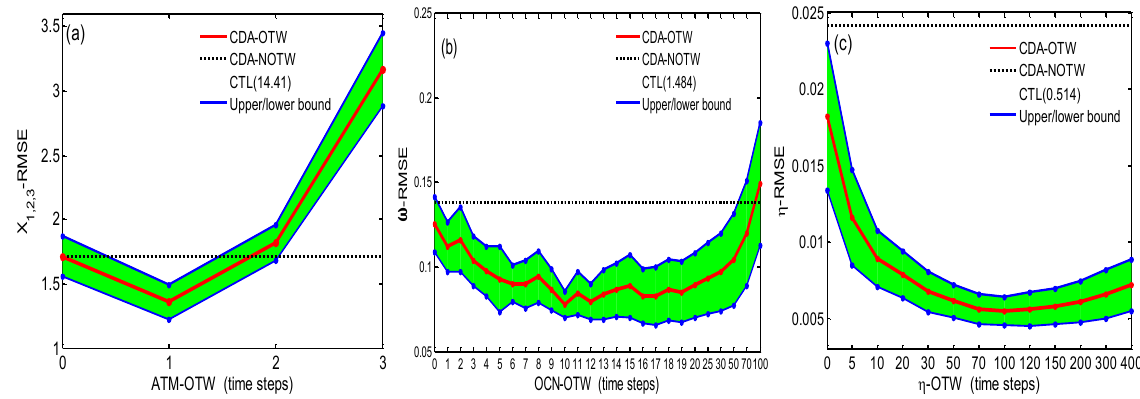
Figure 4. Variations of root mean square errors (RMSEs) of (a) “atmospheric” states X 1 , 2 , 3 (namely, the average of X 1 , X 2 , and X 3 RMSEs) in the space of ATM-OTW length when the “oceanic” state ( ω) only uses a single observation at the assimilation time; (b) “upper ocean” state ( ω) in the space of OCN-OTW length when the ATM-OTW is fixed at 1 as shown in panel (a) (1 for the ATM-OTW, i.e., three observations in each window; see the caption of Fig. 1) but the OCN-OTW (for ω) is varying and (c) “deep ocean” state ( η) in the space of η -OTW length when the “deep ocean” observations are assumed to be valid and the ATM-OTW and OCN-OTW are fixed as 1 and 10, respectively. The experiments are conducted in a perfect model setting with a simple univariate adjustment scheme. The red lines are the 20-case mean, each using different initial conditions taken from different periods in the control integration (see the description in Sect. 2.2), and the blue lines represent the upper/lower bounds (mean ± standard deviations) of the RMSEs. An OTW with the length of 0 represents only assimilation of the observation at the assimilation time (i.e., with no OTW, dashed-black lines). The RMSE values of the control case (no observational constraint, called CTL) are marked in the